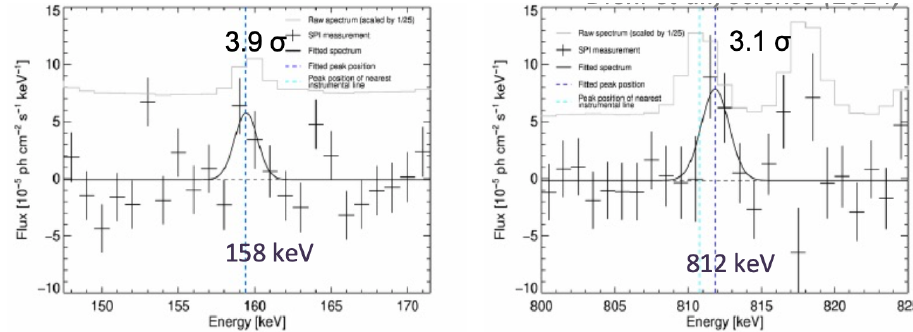
Figure 1. The early detection of decay lines from 56 Ni after 20 days past explosion signify appearance of 56 Ni at surprisingly-low optical depth [14]. Although the significance is at the 4 σ level only, this signifies a deviation from the standard assumption of 56 Ni being at the center of a nearly-spherical explosion. The instrumental background spectrum is indicated as grey histogram, scaled down to fit; the nearest instrumental line positions are indicated by dashed lines (green), while the fitted line centers of the SN2014J signal are also indicated (dashed black